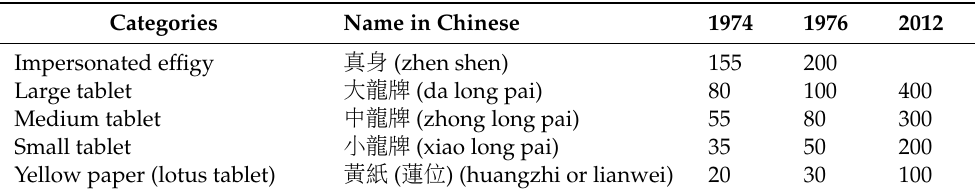
Table 3. Price of ancestral e ffi gies and